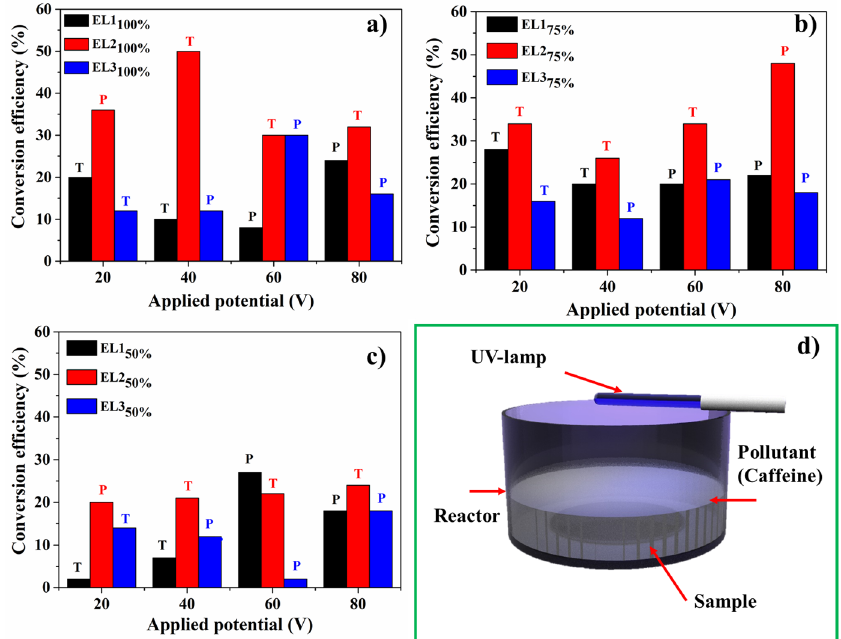
Figure 4. Photocatalytic degradation of caffeine using TNS prepared in different electrolytes (according to Table 1): ( a ) EL1-3 100% , ( b ) EL1-3 75% , ( c ) EL1-3 50% , and ( d ) illustration of the photocatalytic reactor. T—nanotubular; P—porous.